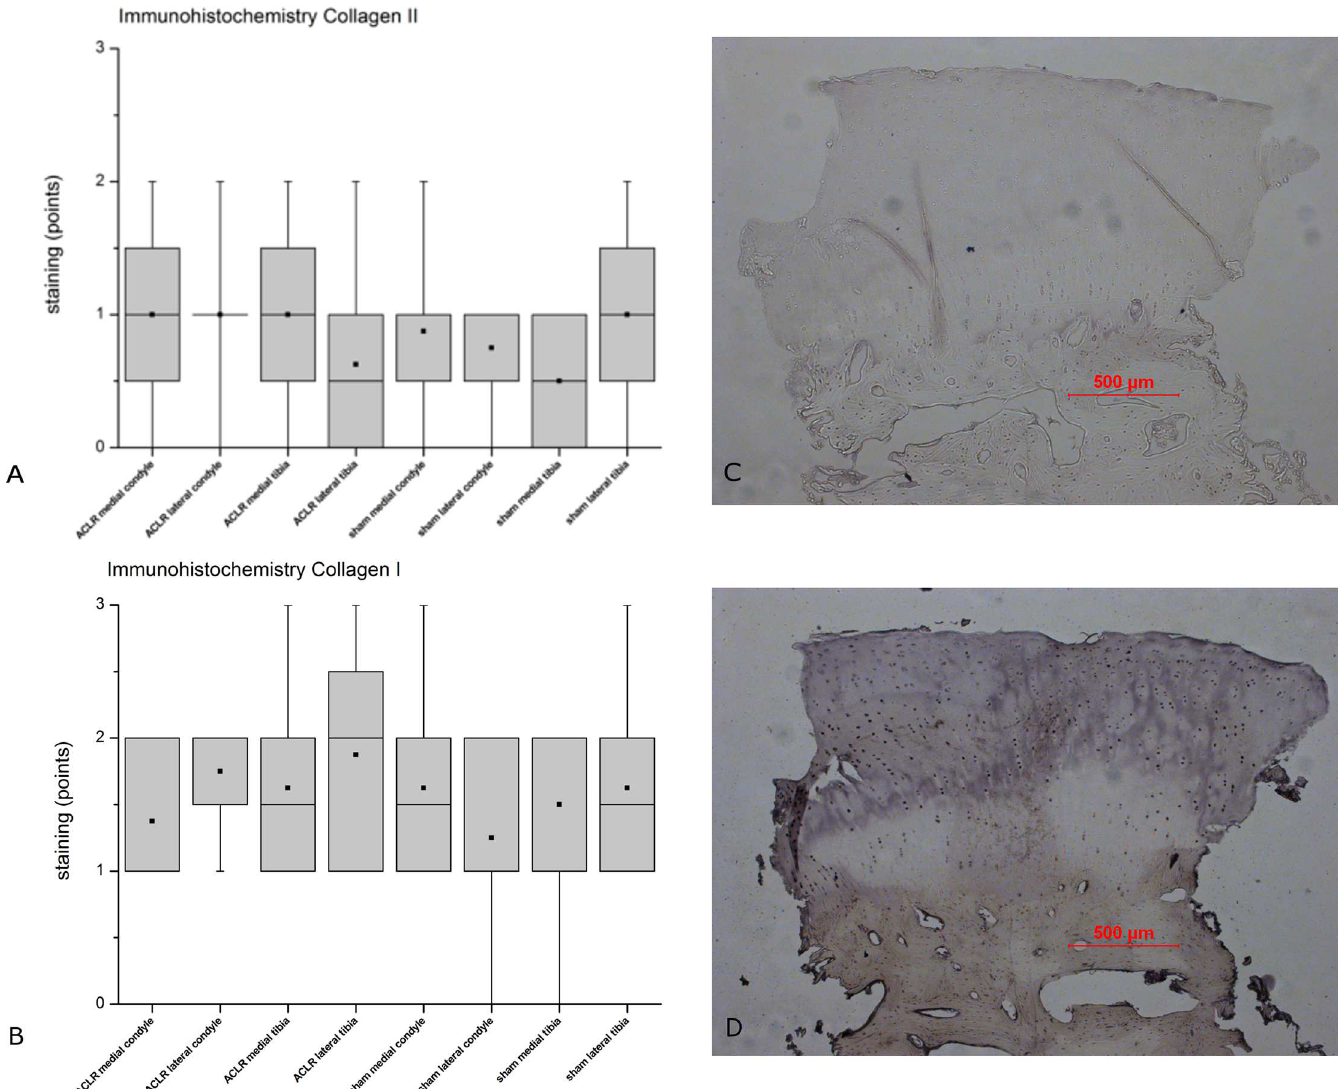
Fig 11. Immunohistochemical staining. Results of the immunohistochemical staining of the examinedregionsof ACLR and sham operated knee joints with A) collagenII and B) collagenI. The score ranges from 0 (no staining) to 3 points. The results indicated no evident differences between the ACLR side and the sham side for neither Col II (A) nor Col I (B). This was in concurrence with our histological results (Fig 2). Sample of an immunhistologicalstaining of collagenII (C) and collagen I (D) from the moderate degenerated (histological score: 9 points) sham operated side of the lateral tibia plateauof animal #8952 with an intense staining for collagen I (3 points) and a weak staining for collagenII (1